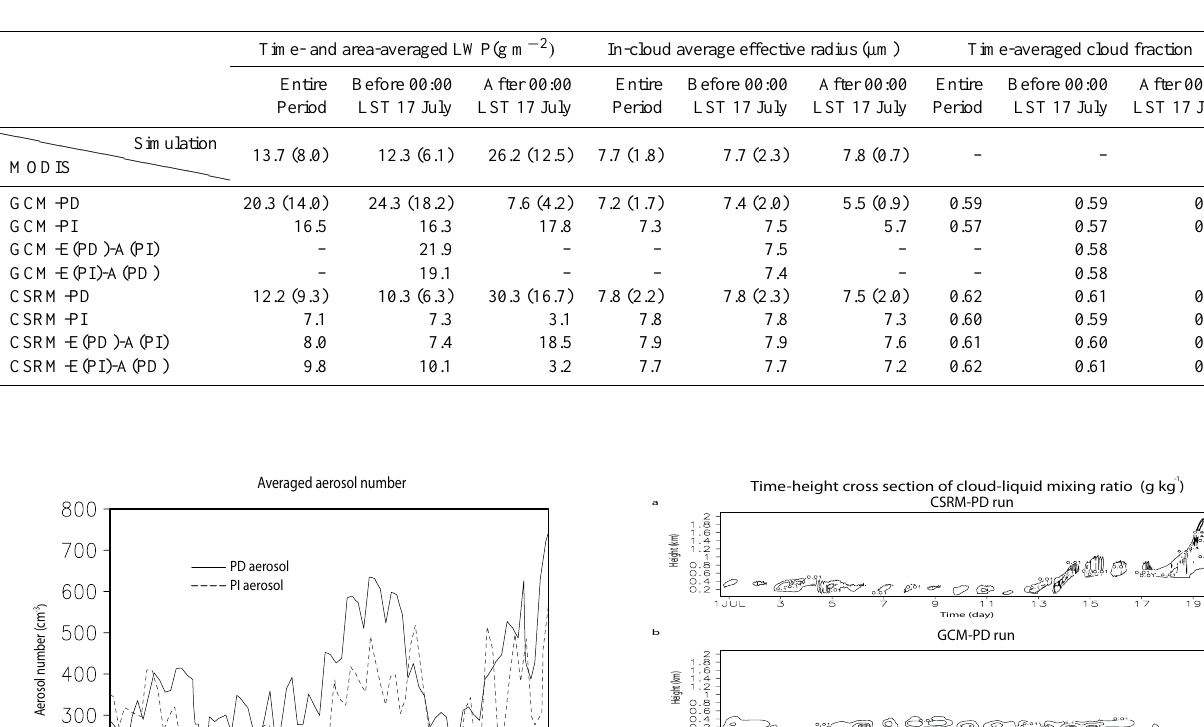
Table 2. Averaged LWP, effective radius, and cloud fraction. The standard deviations of LWP and effective radius in MODIS, the GCM-PD and the CSRM-PD simulations are shown in parentheses for the corresponding average periods.